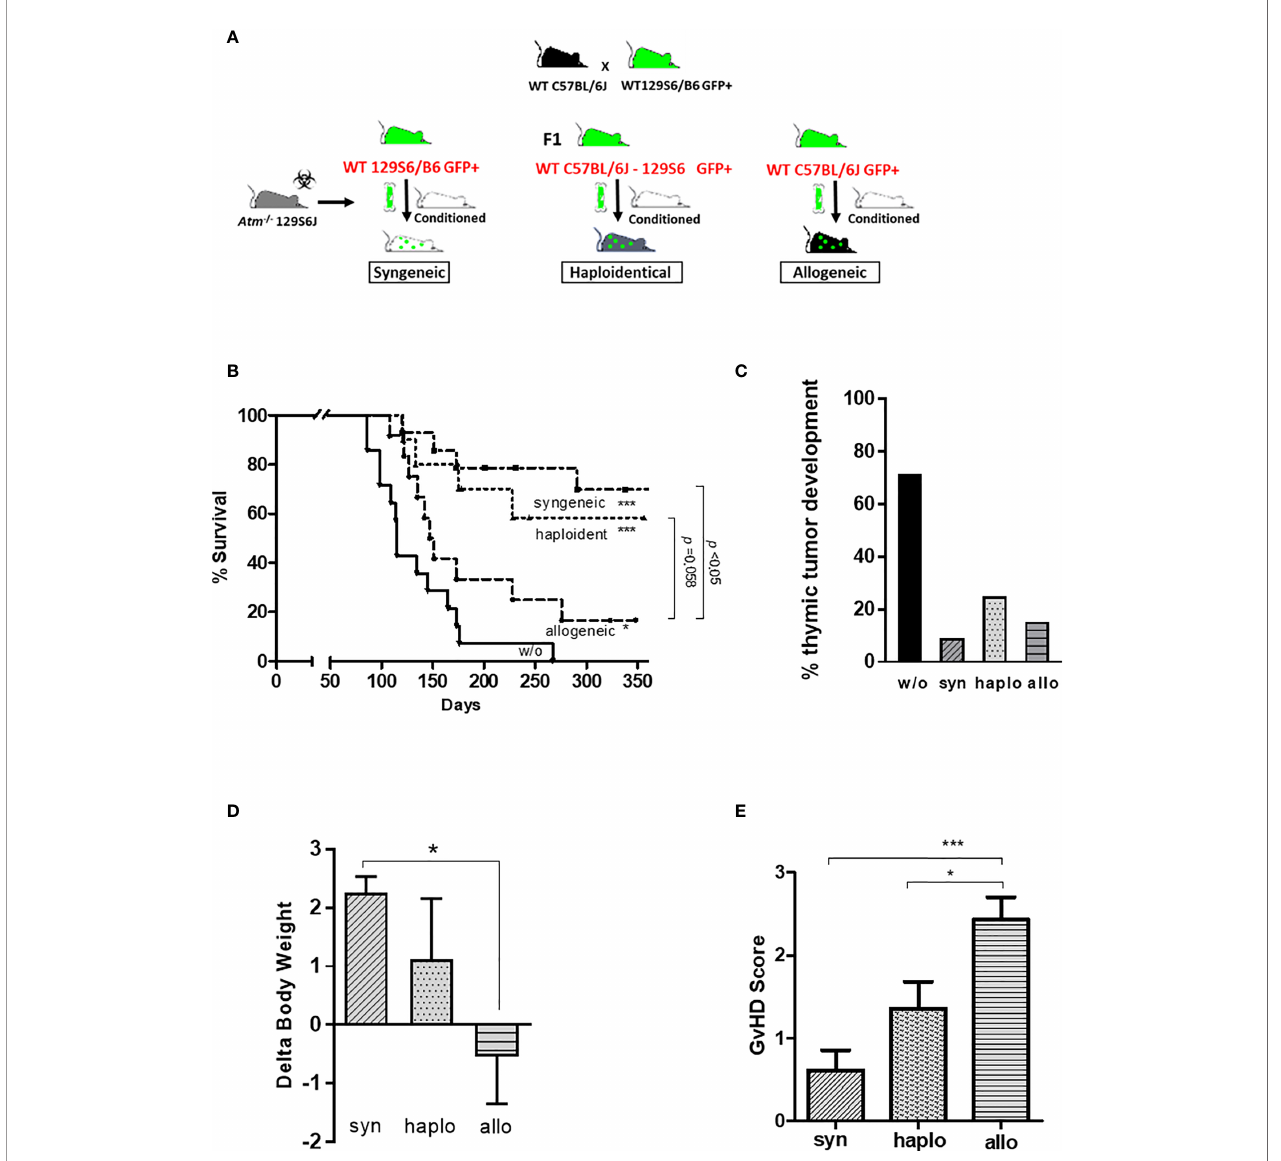
FIGURE 2 | Syngeneic, haploidentical and allogeneic HSCT in Atm -de fi cient mice. (A) Atm -de fi cient recipients received a nonmyeloablative conditioning regimen consisting of anti-CD4 mAb and anti-CD8 mAb together with cyclophosphamide. Lin - selected BMDCs derived from 129/SvEv GFP-transgenic WT mice (syngeneic setting) or derived from mice of the F1 generation of 129/SvEv GFP-transgenic and C57BL/6 WT mice (haploidentical setting), or from WT C57BL/6 mice GFP- transgenic (allogeneic setting) was used for HSCT. (B) Survival curves showed as Kaplan-Meier plots derived from Atm -/- mice (w/o; n = 14) before and after syngeneic (n = 11), haploidentical (n = 12) and allogeneic HSCT (n = 13) (* compared to w/o). (C) Percentage of thymic tumor development in untreated Atm -/- (w/o) and syngeneic, haploidentical or syngeneic transplanted Atm -/- mice. (D) Changes in body weight of Atm -/- mice receiving either BMDCs originated from syngeneic, haploidentical or allogeneic donor mice on the day of the transplantation compared to the end of experiments. (E) GvHD score grading performed throughout the observation period after syngeneic, haploidentical and allogeneic HSCT in Atm -/- mice. Data are presented as mean ± SEM. * p < 0.05, *** p < 0.001. BMDC, bone marrow-derived cells; GFP, green fl uorescent protein; GvHD, Graft versus Host Disease; HSCT, hematopoietic stem cell transplantation; mAb, monoclonal antibody; WT,